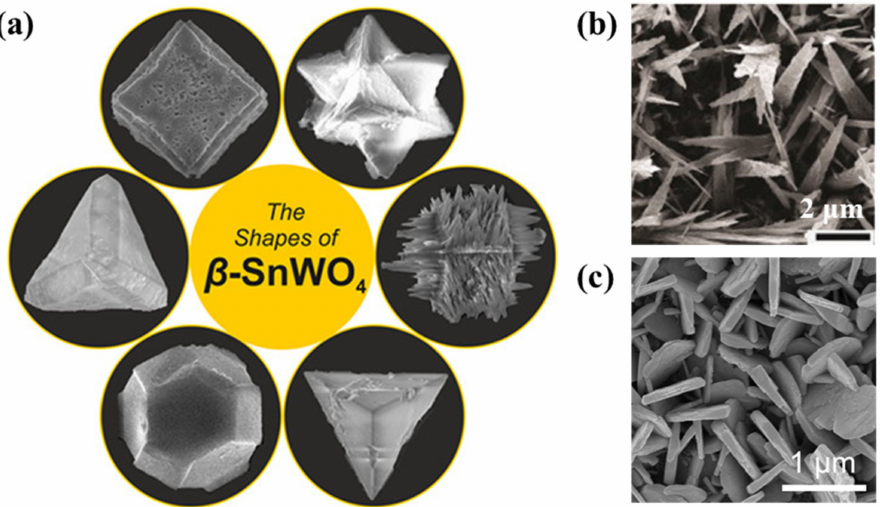
Figure 4. ( a ) Different shapes of β -SnWO 4 [45]; α -SnWO 4 with ( b ) dense nanorods [27] and ( c ) nanosheet [56]